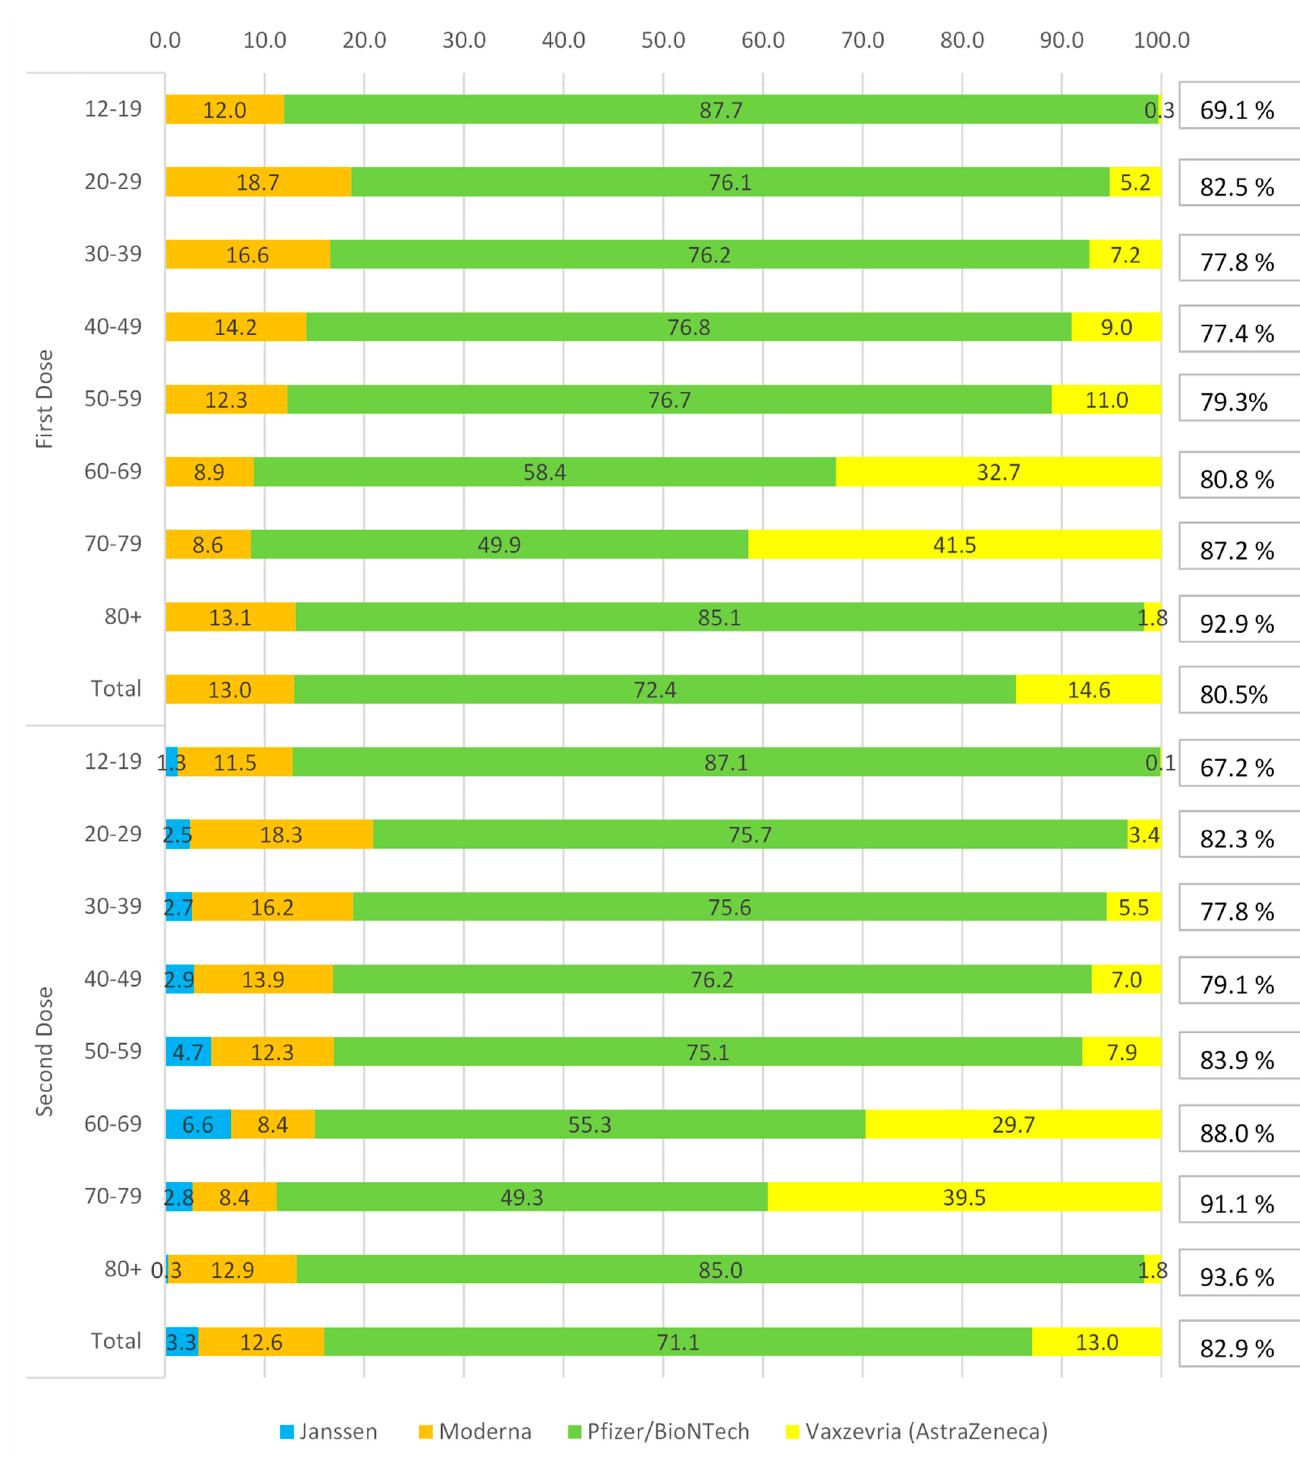
Figure 7. Percentages of administrations by age group, according to type of vaccine with reference to the first and second doses. The percentages on the right show the vaccination coverage achieved by the relative age groups. The coverage percentages of the total population are calculated with respect to the vaccinable population aged 12 and over, and not with respect to the Italian population.